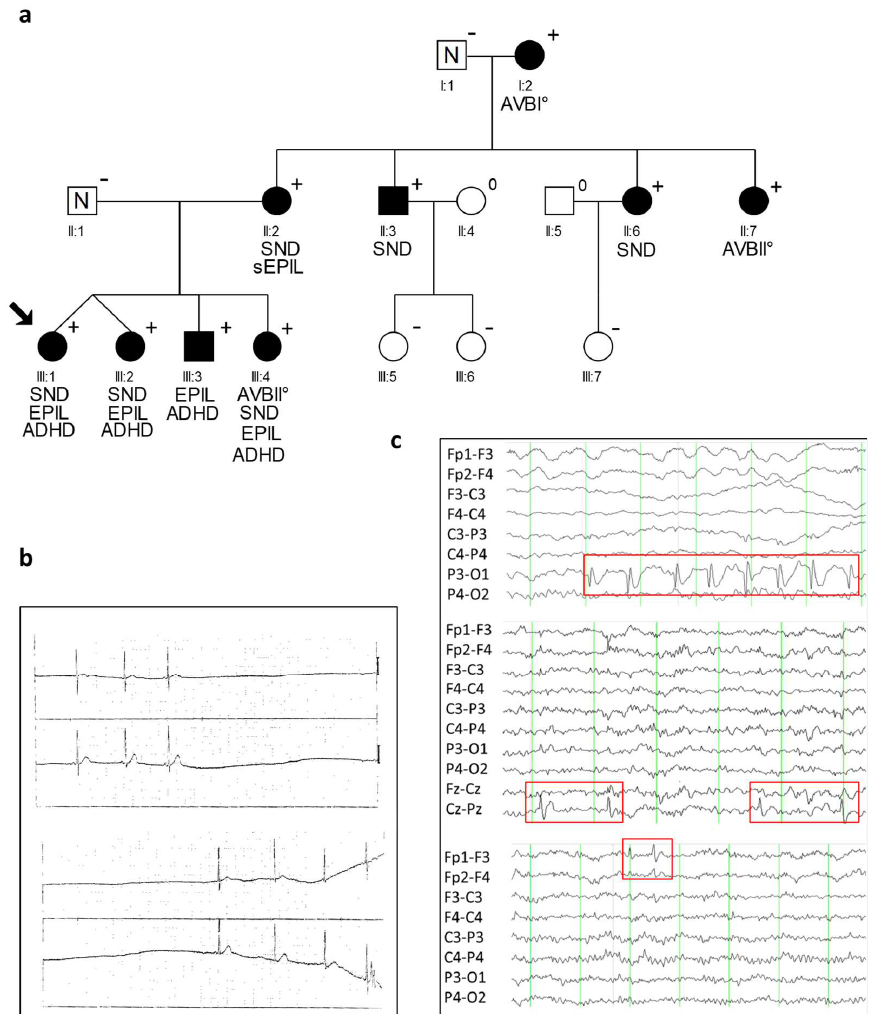
Figure 1. Identification of the heterozygous CACNA1D variant R390H. ( a ) Pedigree of the family with a combined clinical phenotype of cardiac and extra-cardiac symptoms with a heterozygous CACNA1D variant (p.Arg930His; shortly: R930H) and autosomal dominant syndromic form of SND and epilepsy. Men are denoted by squares, woman by circles. Filled symbols represent clinically affected family members; N indicates family members without a diagnosis of SND or epilepsy, + presence of the heterozygous variant R930H, − absence of the heterozygous variant R930H, 0 not tested. The proband is indicated by an arrow. Characteristics of cardiac and neurologic phenotypes are indicated below (SND, sinus node dysfunction; AVB, atrio-ventricular block; Epil., epilepsy; sEpil., suspected epilepsy; ADHD, attention deficit hyperactivity disorder). ( b ) ECG of proband (III:1) at age 5 years with documented sinus arrest, and ( c ) EEG of 3 CACNA1D variant carriers demonstrating occurrence of sharp waves with different localization. Above: EEG of family member III:I at the age of five shows occipital sharp waves (P3-O1) and bulbus artifacts (Fp1 and Fp2). Middle: EEG of family member III:2 at the age of 10 with central sharp waves (Cz-Pz). Down: EEG of index case (III:1) at the age of 10 years with left frontal sharp waves (Fp1-F3). The red boxes indicate abnormal EEG changes. Fp = most frontal leads; F = frontal; C = central; p = parietal; O =